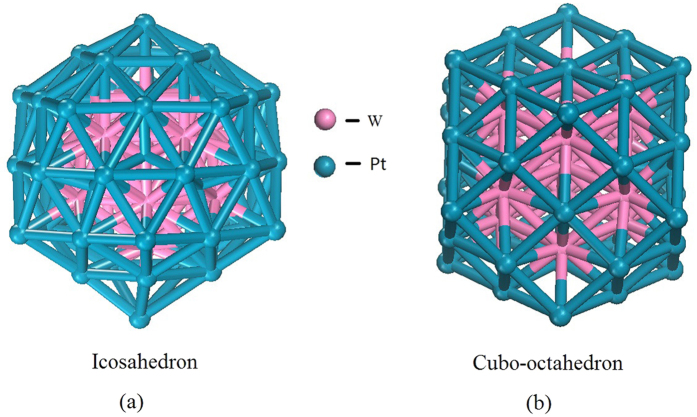
The different isomeride structures of W13@Pt42.